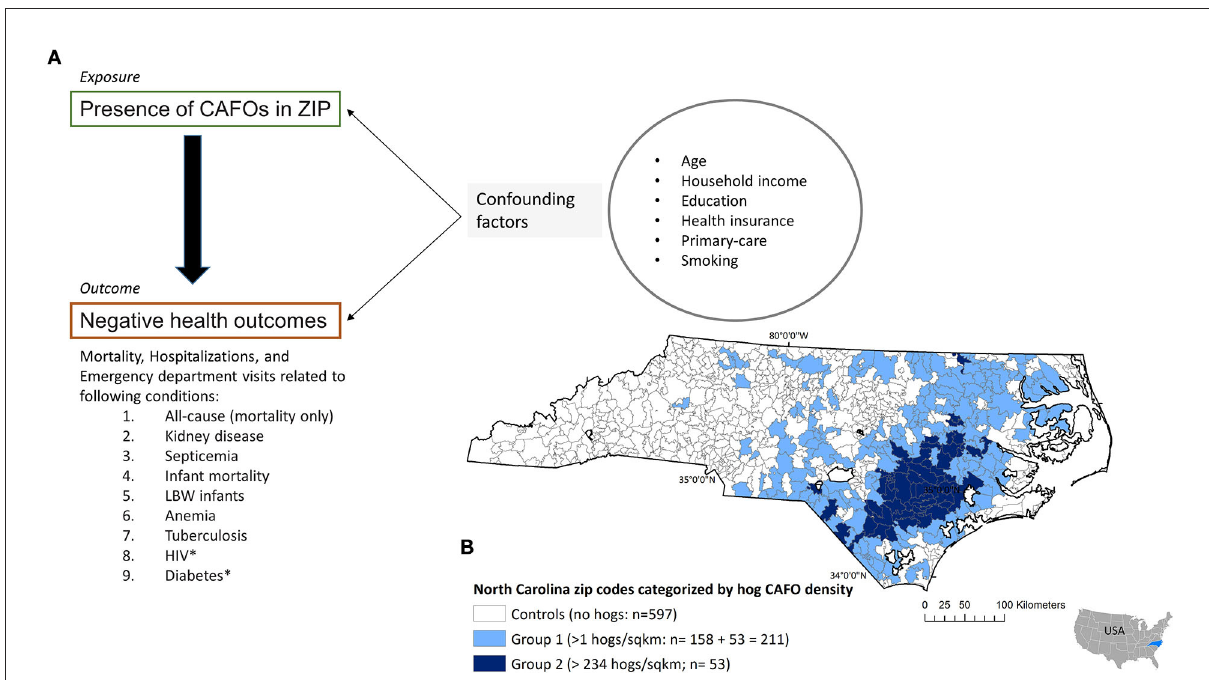
FIGURE1 (A) Directed acyclic graph denoting the associations between exposure, outcome, and potential confounding factors. (B) Division of zip codes in North Carolina based on the swine (i.e., hog) density. The zipcodes were divided into three groups: Group 1 ( > 1 hogs/square kilometer; n = 211), Group 2 ( > 234 hogs/sqkm; Group 2 is a subset of Group 1), and control zip codes. The threshold of 234 hogs/sqkm was the upper quartile of the hog density [Comparable to the method by Kravchenko et al.